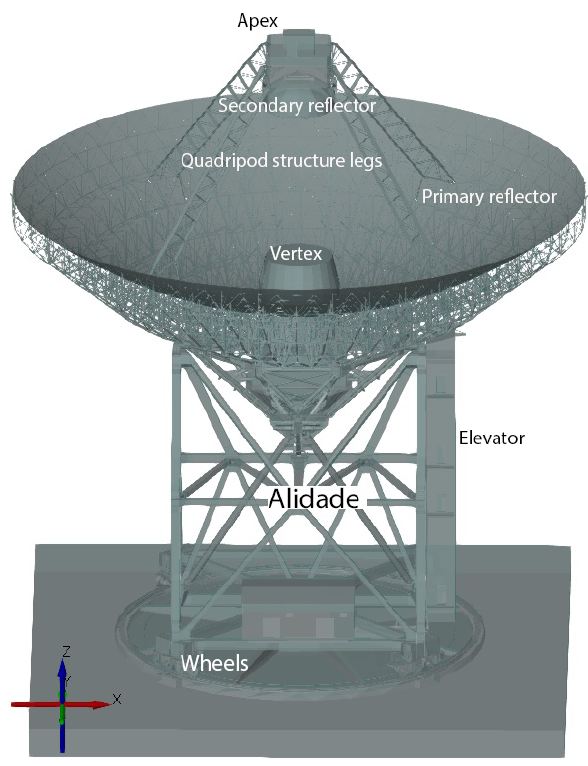
Figure 2: The Sardinia Radio Telescope 3D